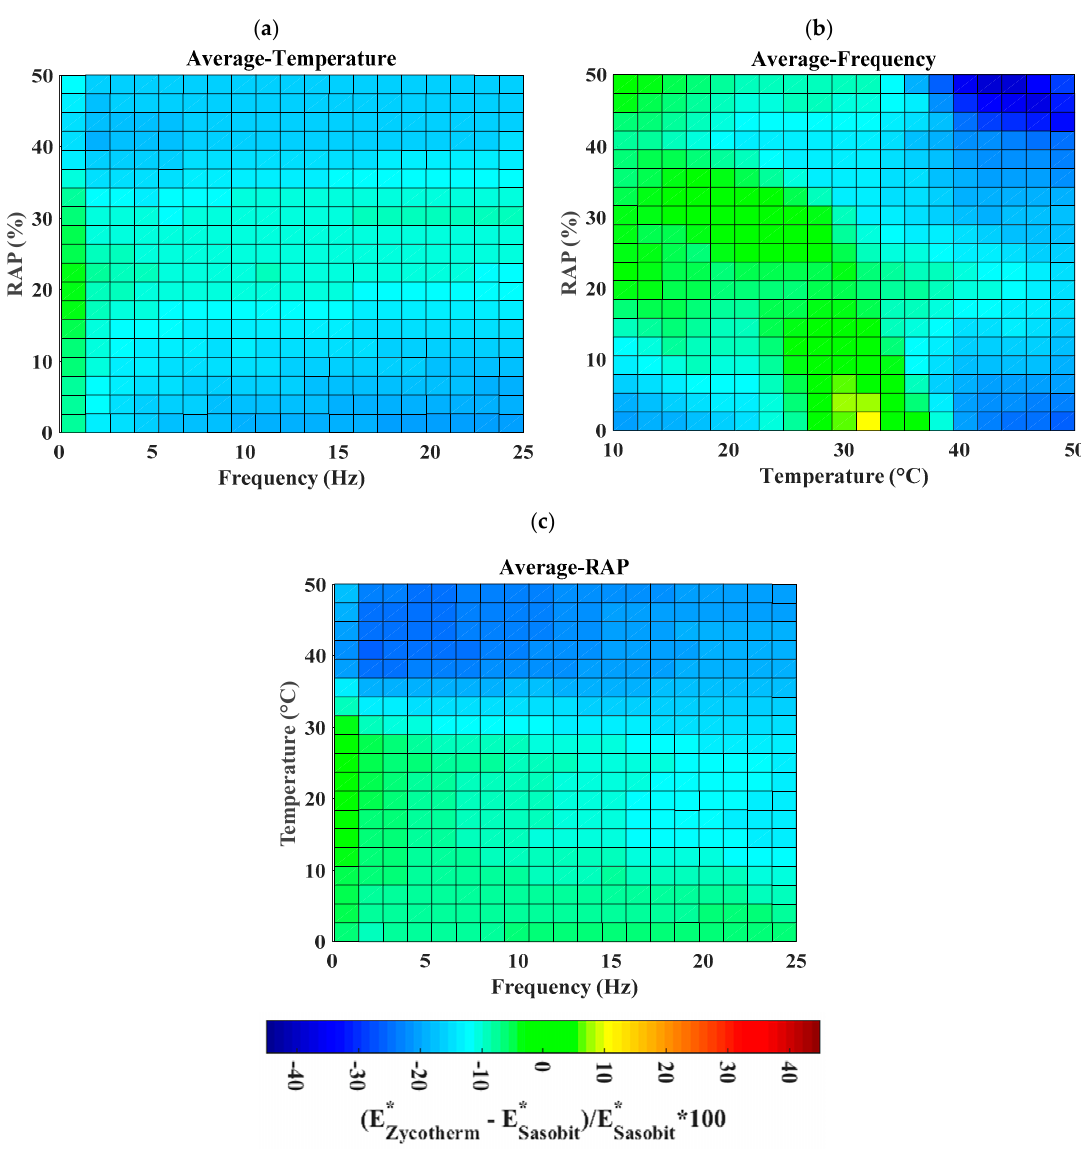
Figure 11. Surfaces of average values of ∆ in function of ( a ) temperature, ( b ) frequency, and ( c ) RAP, respectively.